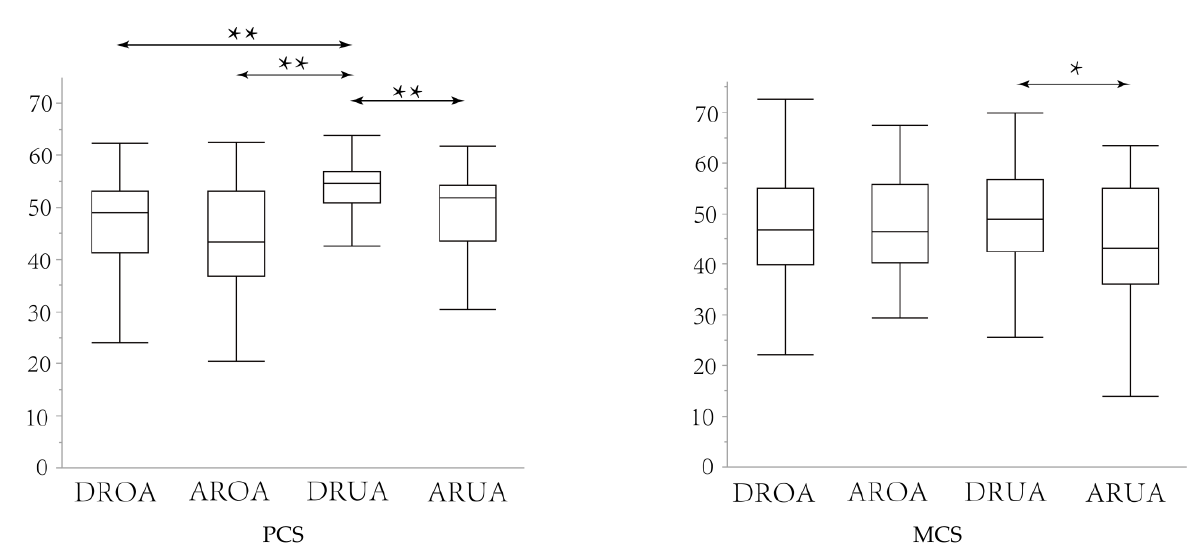
Figure 3. PCS and MCS (* p < 0.05, ** p < 0.01).